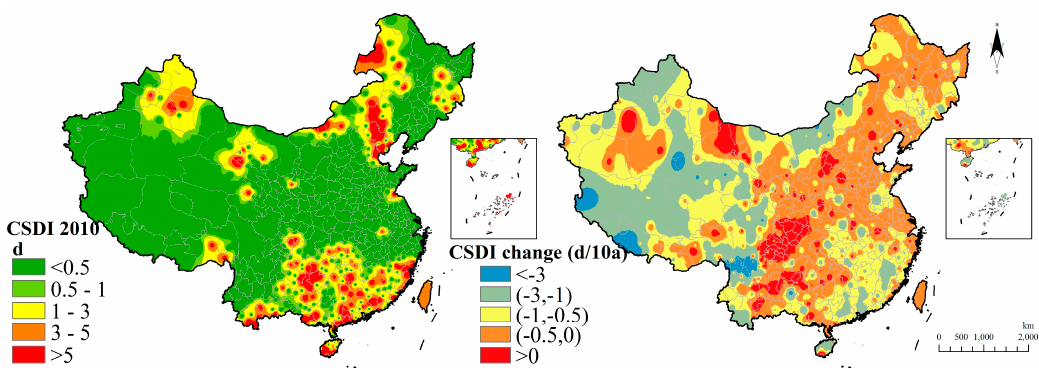
Figure 8. Cold spell duration indicator distribution and change.